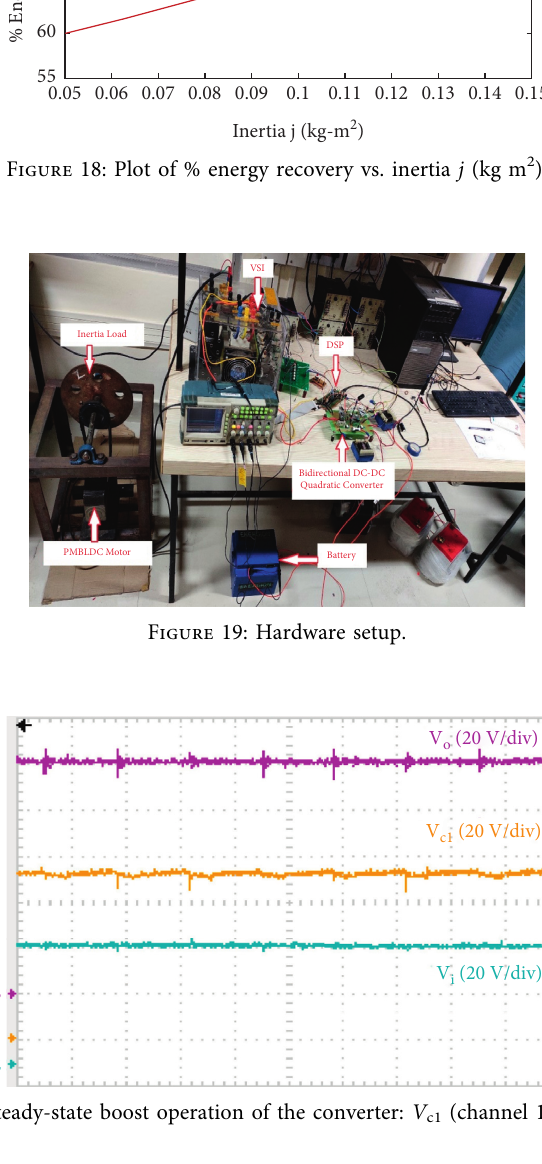
c1 (channel 1); V i (channel 2); V o (channel